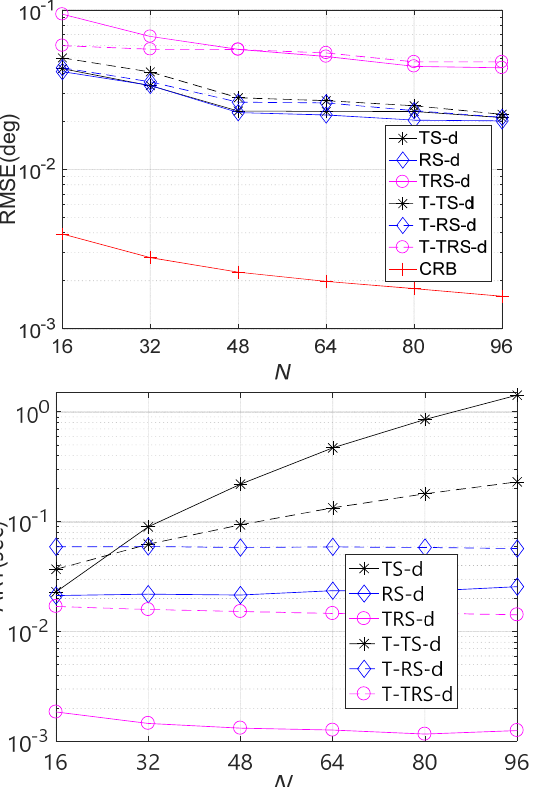
Figure 7. RMSE comparisons versus target distance Δ in Case (I). 6. Conclusions In this paper, three estimators based on PARAFAC decomposition are introduced for 2D-DOD, 2D-DOA, 2D-TPA, and 2D-RPA estimation in a bistatic EMVS-MIMO radar with coherent targets. The core idea of the proposed estimators is to de-correlate the coherent targets via spatial smoothing and then formulate the covariance matrix into a